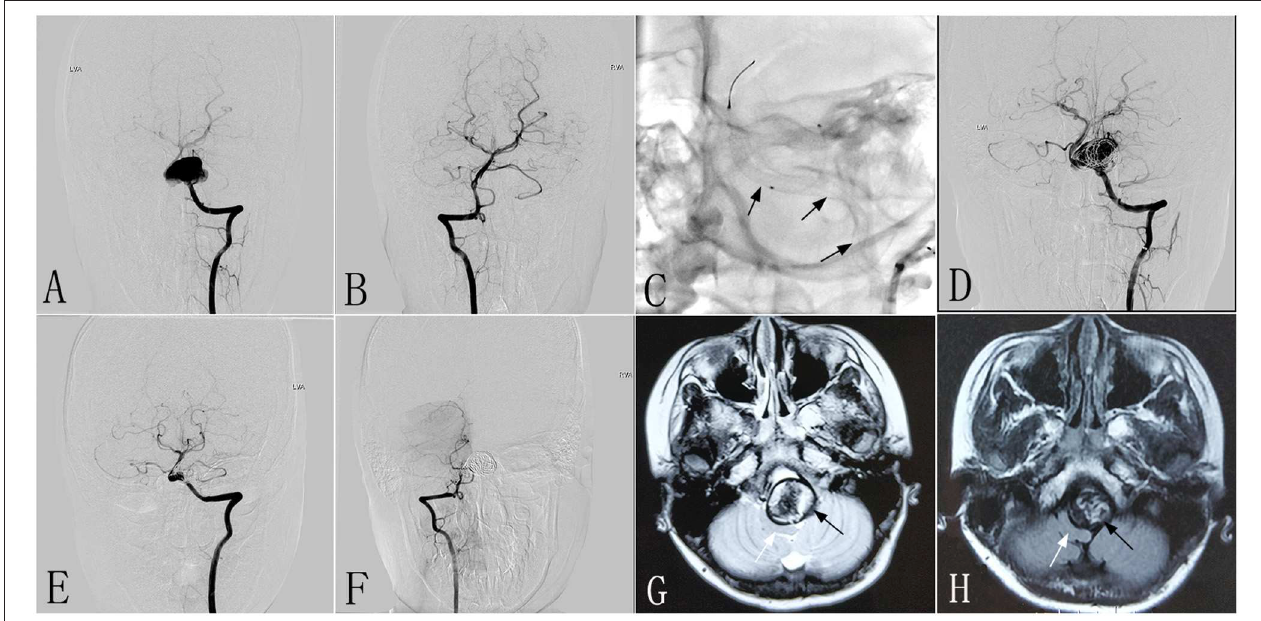
FIGURE 1 | Images from a 10- to 12-year-old patient with a left vertebral dissecting aneurysm (case 1). (A) Preoperative anteroposterior angiogram showing a giant dissecting aneurysm in the LVA. (B) Preoperative anteroposterior angiogram demonstrating the patency of the RVA. (C) Intraprocedural unsubtracted view showing the location of the PED (4.5 × 35mm). (D) Immediately postoperative angiogram of the LVA demonstrating the reconstruction of the parent vessel, and contrast stasis in the lumen of the aneurysm. (E,F) Six-month post-treatment anteroposterior angiograms showing the patency of the LVA (E) and the complete occlusion of the RVA (F) . (G,H) Six-month post-treatment MRI (H) compared with preoperative axial MRI (G) demonstrating reduction of the aneurysm size (black arrow) and increased space around the brainstem (white arrow). LVA, left vertebral artery; RVA, right vertebral artery; PED, pipeline embolization